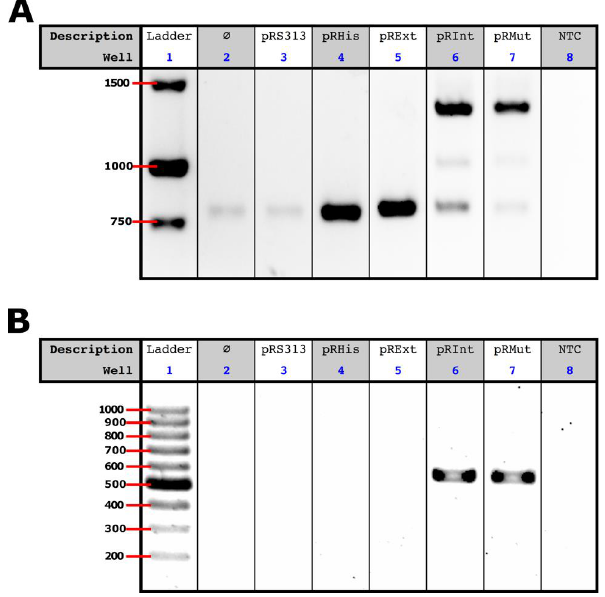
Figure 4. RT-PCR for evaluation of CnePrp8i presence at the RNA level. ( A ) Gel electrophoresis of RT-PCR products for the full URA3 coding sequence; and ( B ) for the CnePrp8i coding sequence. The empty symbol ( ∅ ) stands for non-transformed yeast cells and NTC stands for non-template control.